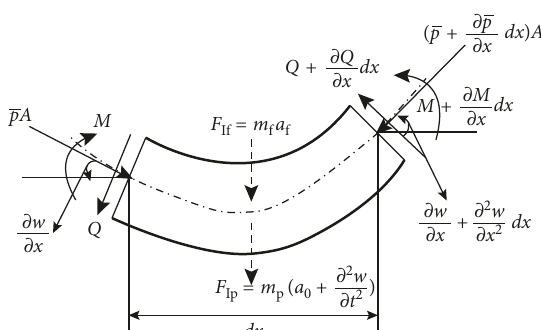
Figure 3: Free body diagram of a pipe